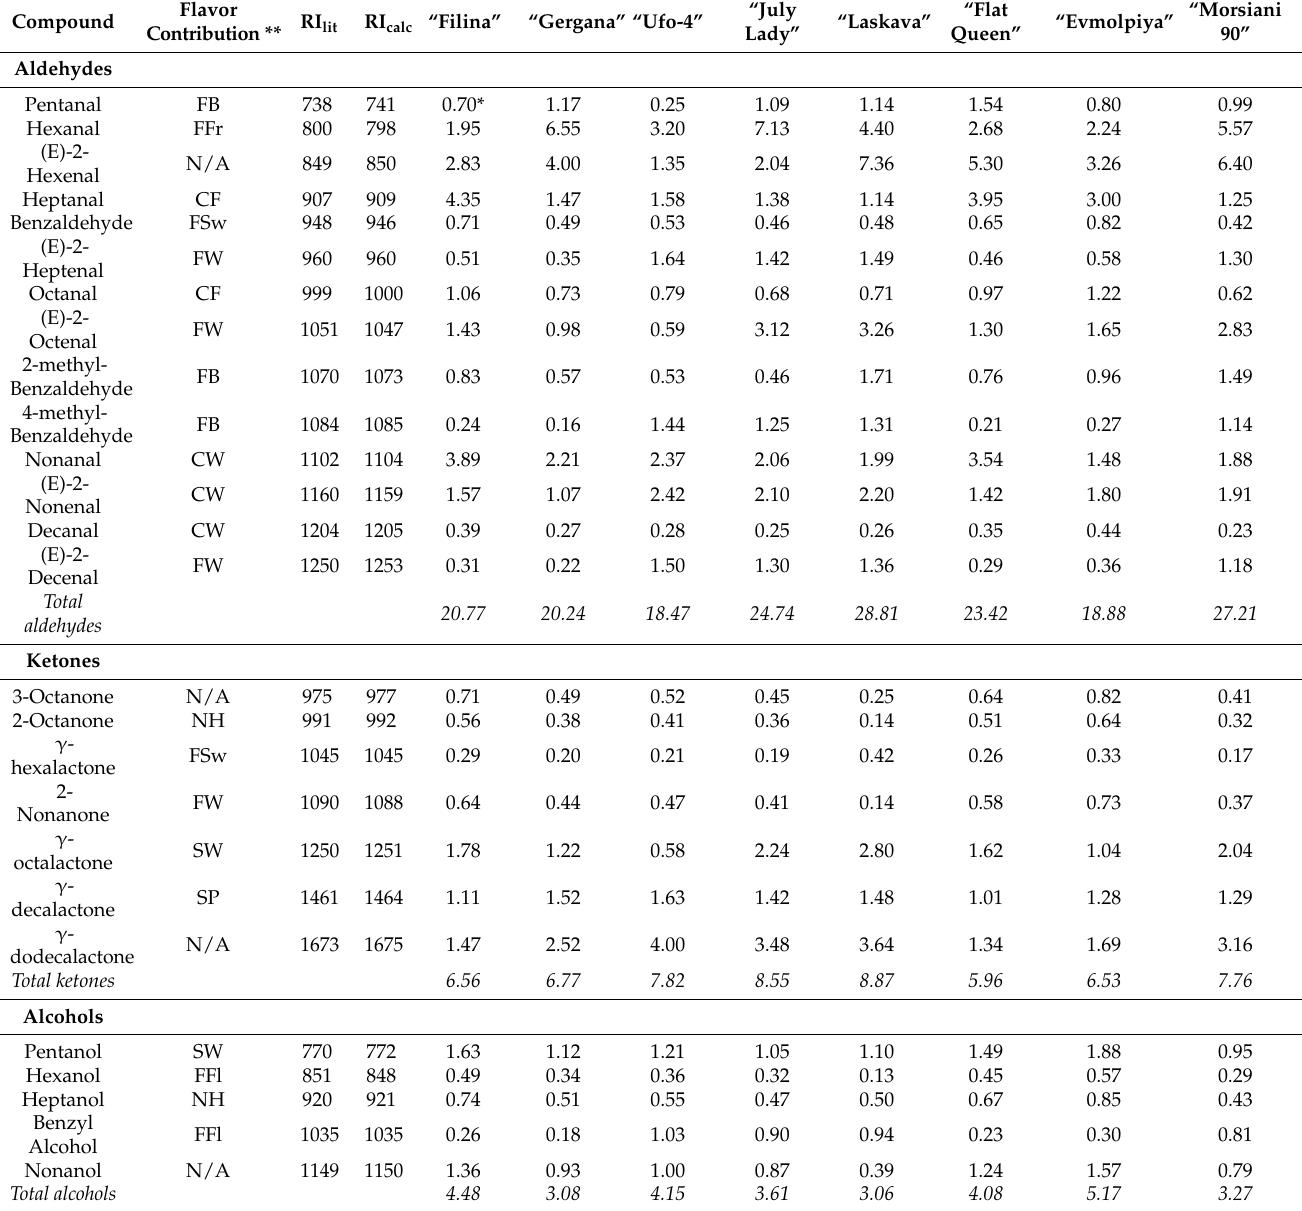
Table 1. Identified volatile compounds in peach varieties analyzed by GC–MS. The results are given as % of Total Ion Current